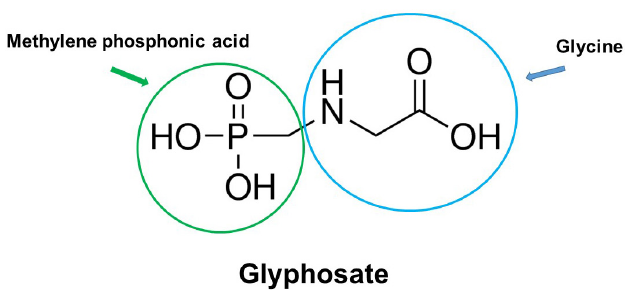
FIGURE 1 - Glyphosate (GLY) or N -(phosphonomethyl)glycine (molecular mass: 169.07) is the most widely used herbicide in Brazil and elsewhere. GLY molecule consists of two moieties (glycine and methylene phosphonic acid) which don’t carry any genotoxic alert and have no oxidative reactivity. After absorption in the GI tract, GLY undergoes no subsequent biotransformation and is excreted (unchanged) in the